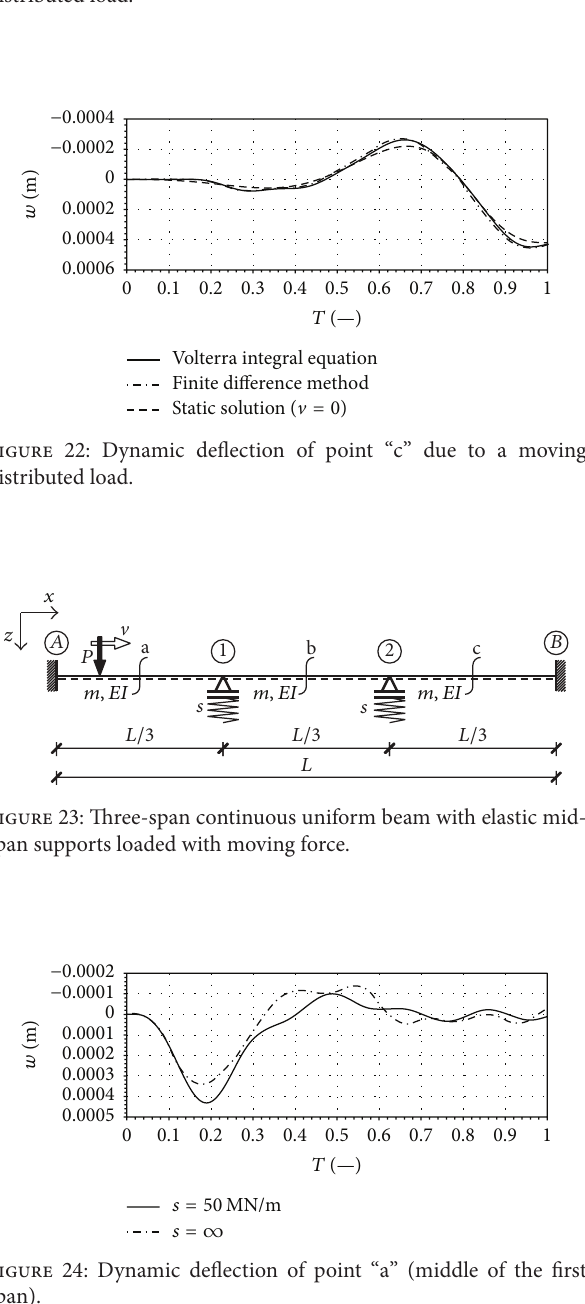
Figure 21: Dynamic deflection of point “b” due to a moving distributed load.